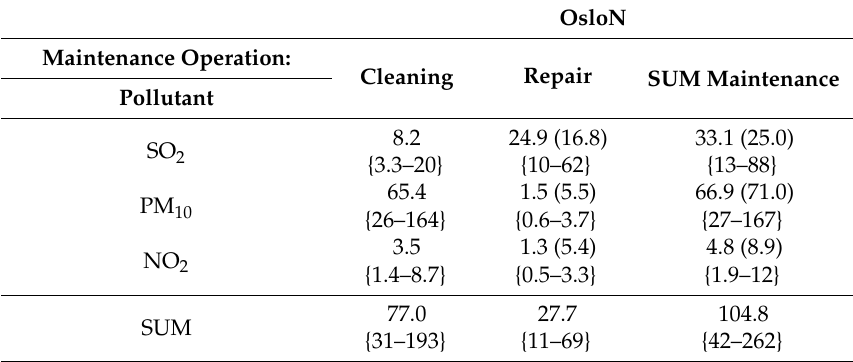
Table 7. Marginal maintenance cost for façades due to atmospheric wear per kg emission of air pollutants (Euro / kg), in Oslo, applying the façade inventory for Norway in Table 4. The values in round brackets () show the results if the pollution impact on the painted materials (of steel, other metals, and wood) was attributed equally to SO 2 , PM 10 , and NO 2 , rather than to SO 2 only. The values in curly brackets {} show the ranges for the damage costs within an uncertainty of two point five